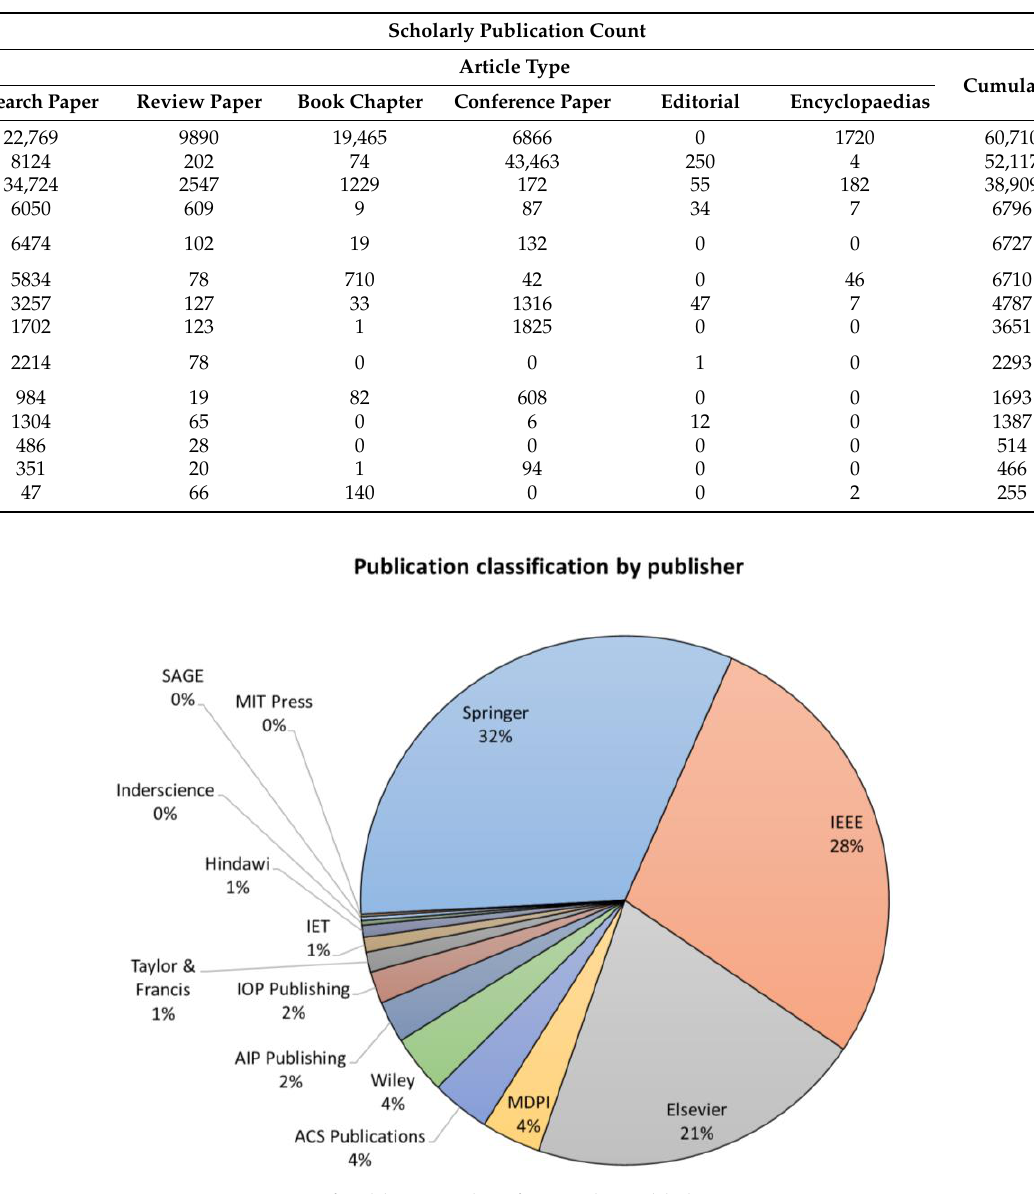
Figure 4. Proportion of publication classification by article type.